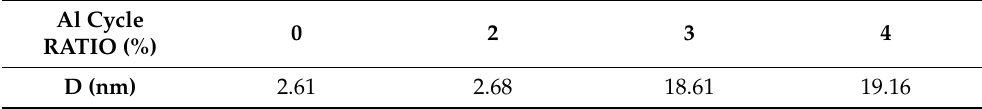
Figure 4. ( a ) XRD spectra of ZnO and AZO films. ( b ) Maximum height and FWHM of (100) peak of ZnO and AZO films. ZnO and AZO films were deposited on glass substrates. Table 1. Grains size of ZnO and AZO films. (100) orientation.